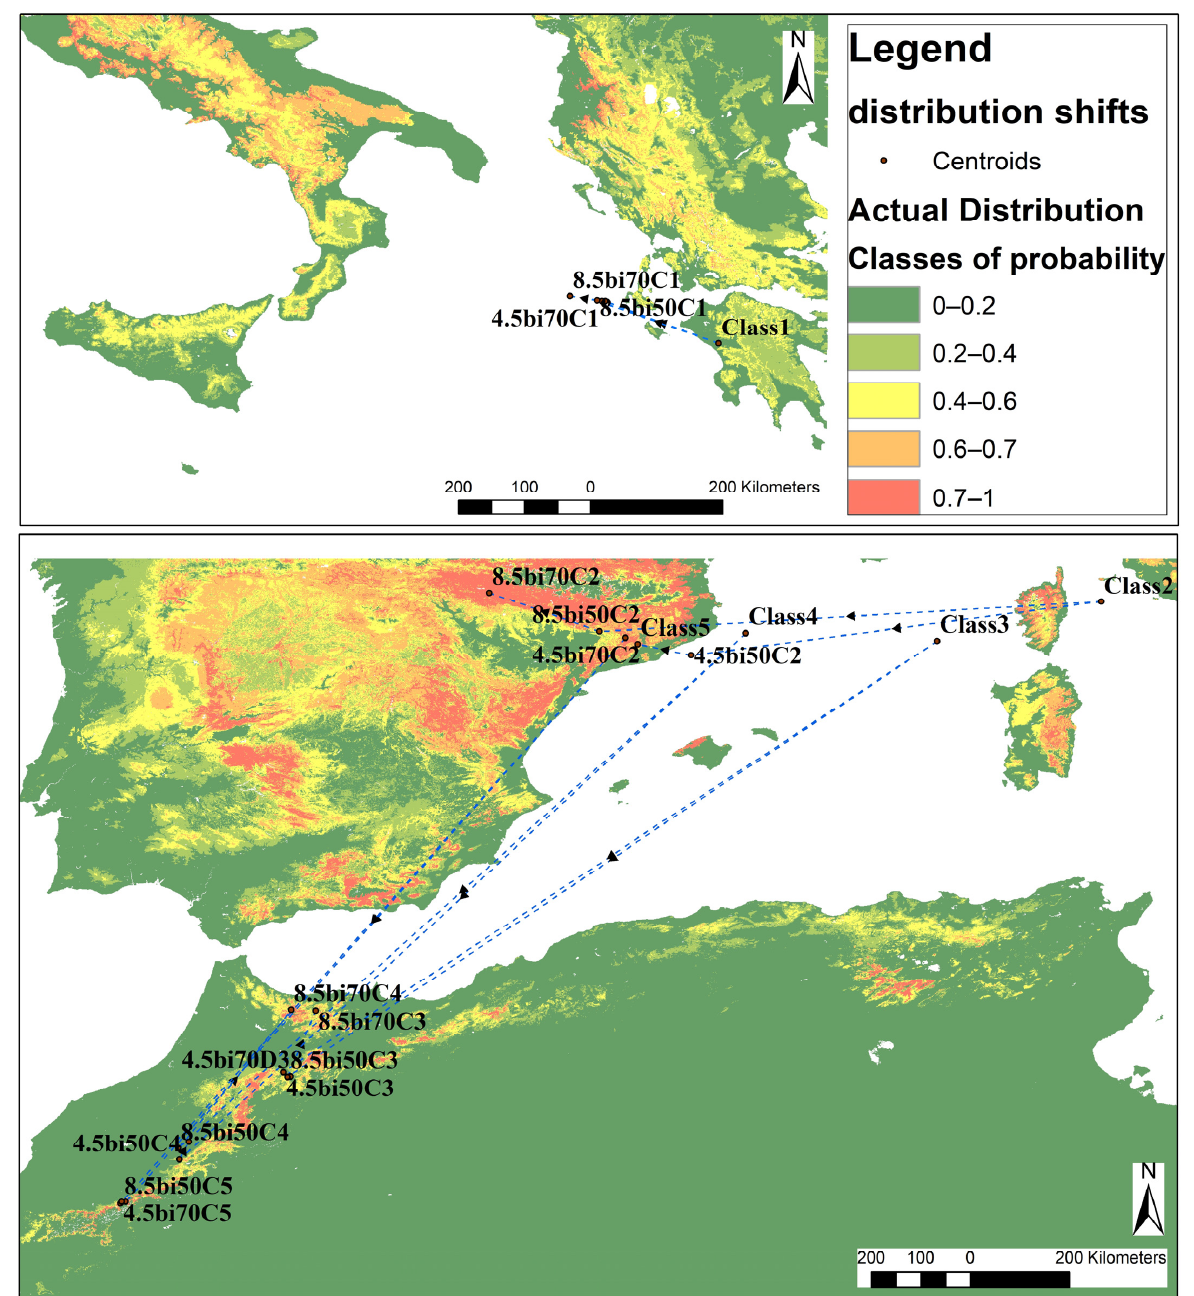
Figure 9. Shifting in the centroids of suitability classes of Acer monspessulanum between actual and future predictions (the shifting direction is explained by the sense of the arrows and the dotted lines).